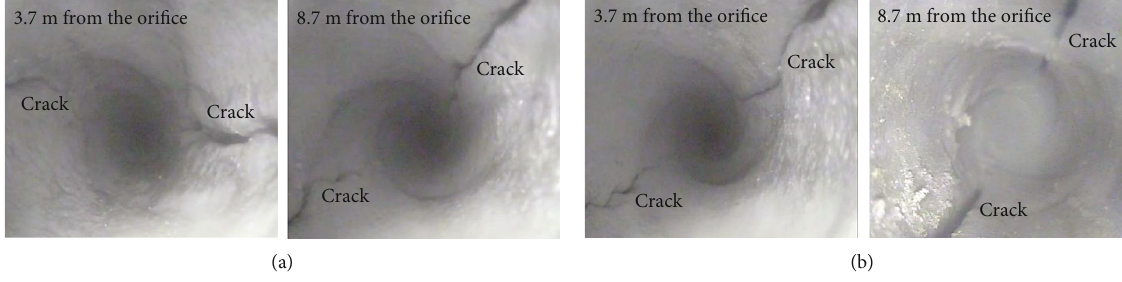
Figure 11: E ff ect of on-site directional roof cutting: (a) SCB and (b)